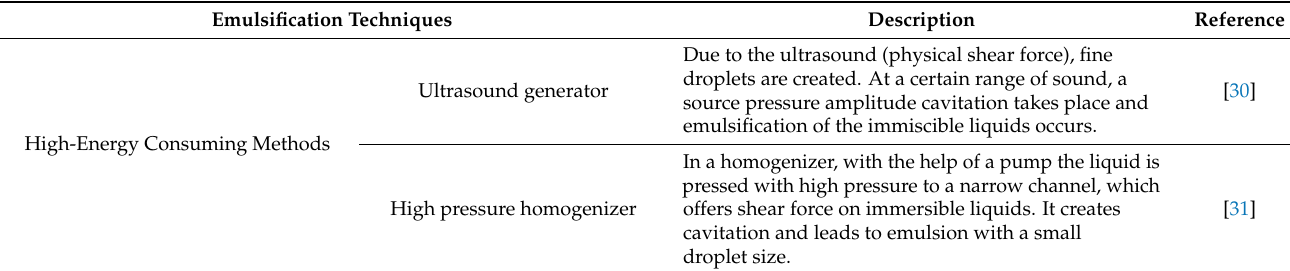
Table 1. Summary of different emulsification